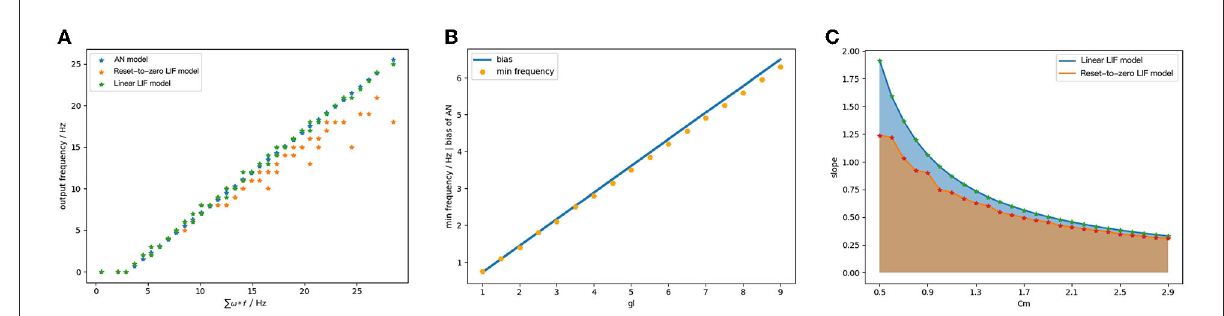
FIGURE8 (A) The output of ReLU-AN model, Reset-to-Zero LIF model and Linear LIF model when the input signals have different frequencies. (B) The relationship between membrane conductance gl and the bias. (C) The relationship between membrane capacitance C m and slope of activation function.